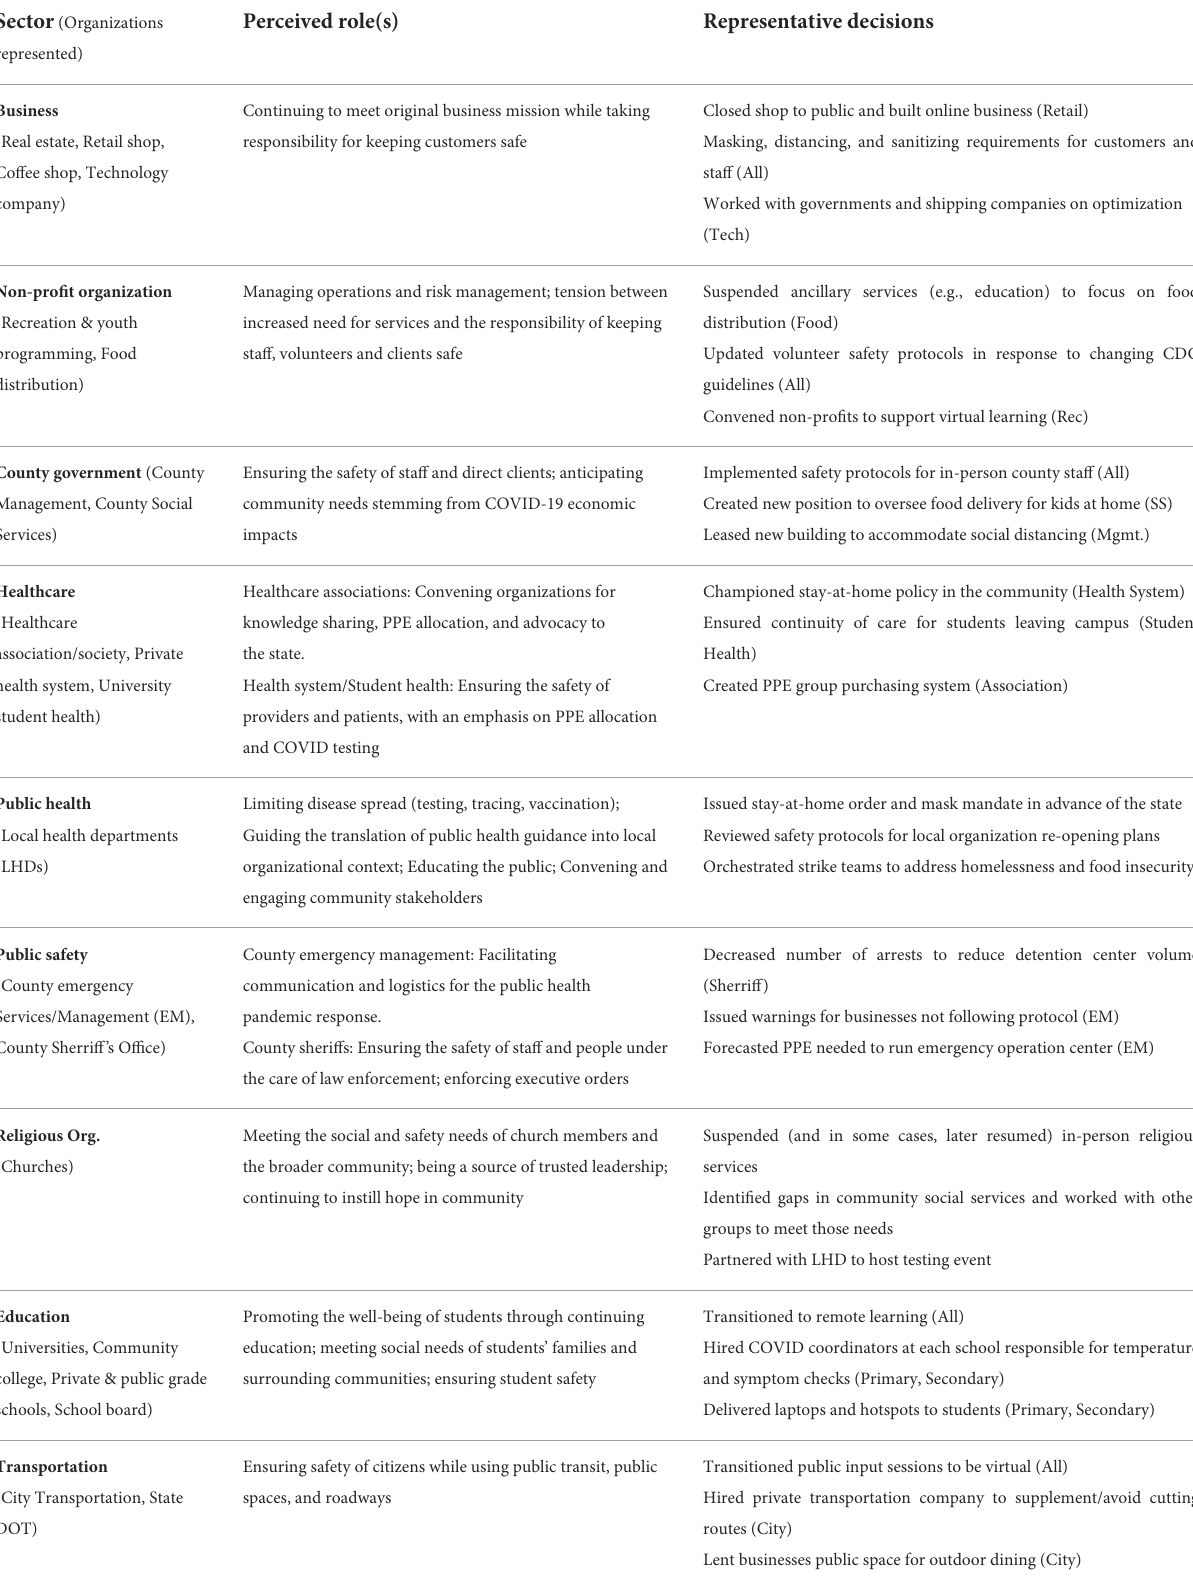
TABLE 3 Organization roles and key decisions among interviewees ( N =